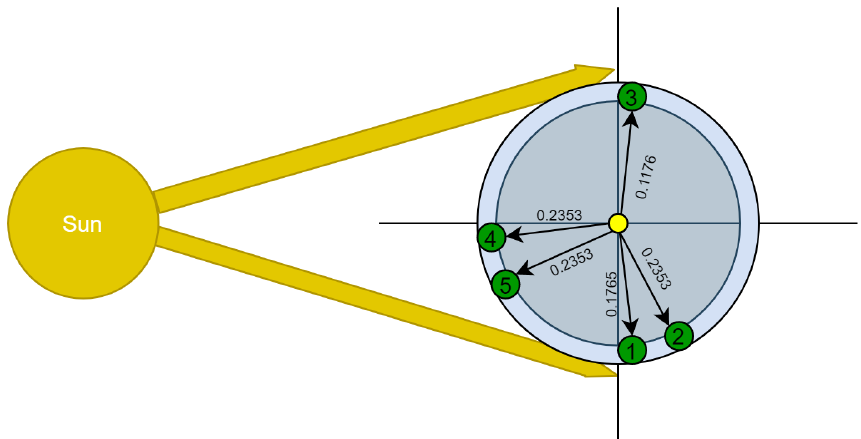
Figure 5. GRAFT model applied on the studied case. Green nodes (1–5) represent the first to fifth sessions, respectively. The yellow node represents the central node. Weights of edges represent the ratio of adjacent session’s cycles to the total daily